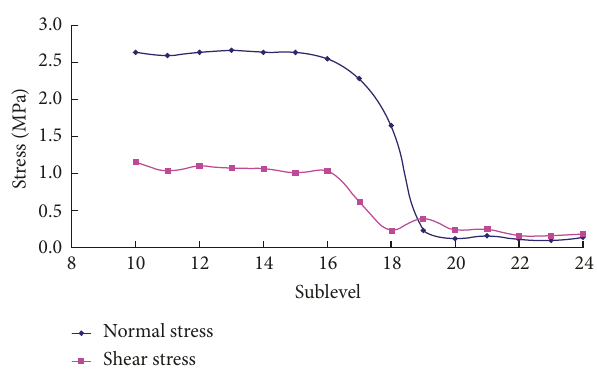
Figure 13: Relationship of stress state of fault F4 with mining